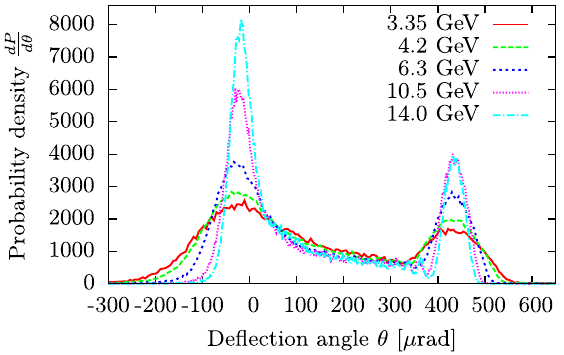
ffiffiffiffi p E (Fit 2), see Eq.